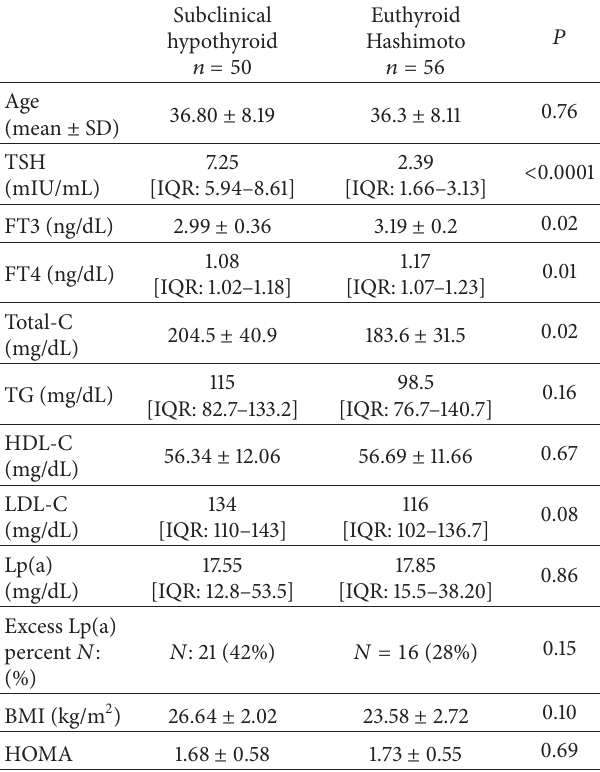
Table 4: Demographic and laboratory results of the subclinical hypothyroid and euthyroid Hashimoto